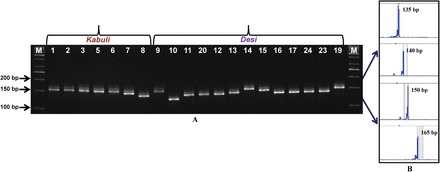
Allelic variation detected among a representative set of 20 desi and kabuli genotypes using the normal unlabelled and fluorescent dye-labelled CNMS marker designed from the flanking sequences of the (GAA)18 repeat motif present in the signal sequence-binding site (CTGAAGAAGAA) of the TL1ATSAR regulatory element containing the bZIP (basic leucine zipper) TF gene by gel-based assay (A) and automated fragment analyser (B), respectively. A maximum of four polymorphic alleles were amplified by the genic CNMS marker among chickpea genotypes using the gel-based assay (A) and automated fragment analyser (B), respectively. The fragment sizes (bp) of all amplified polymorphic alleles are indicated. The identities of genotypes correspond to serial numbers that are provided in Supplementary Table S1 at JXB online. (This figure is available in colour at JXB online.)